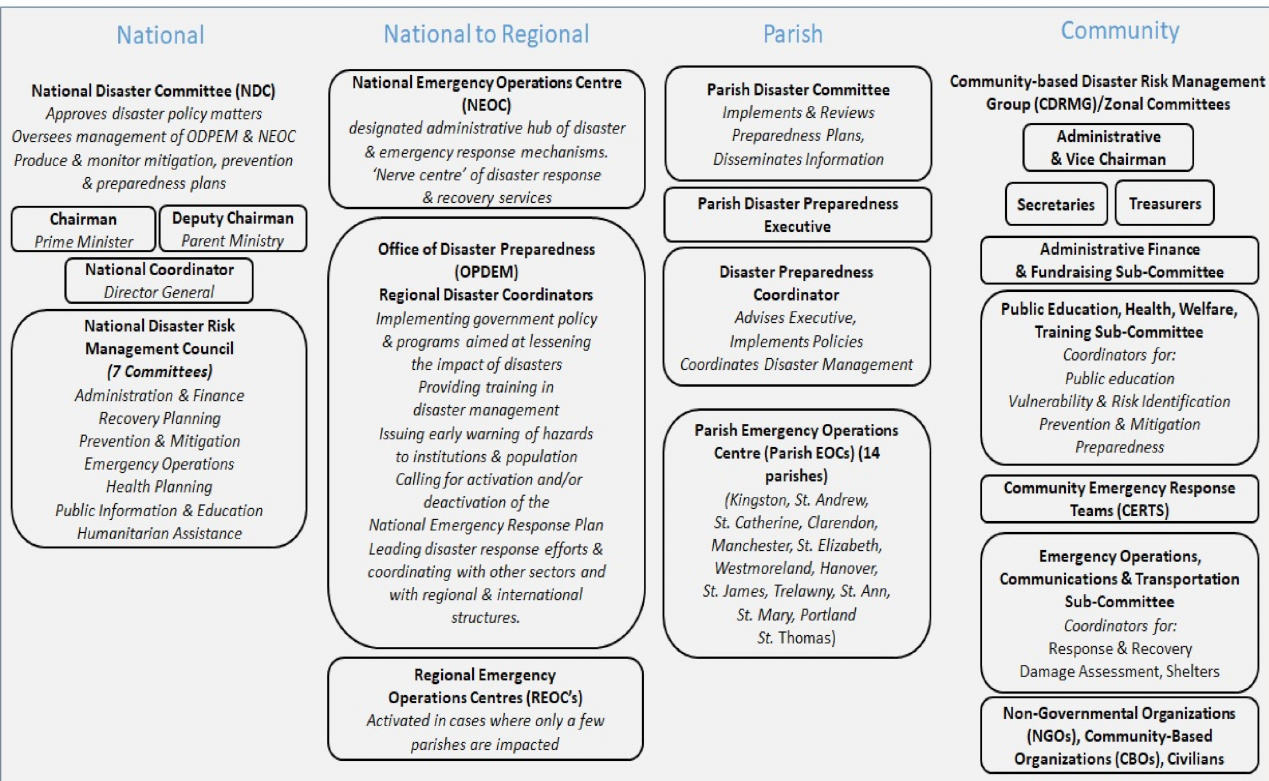
Figure 1. Jamaica’s Disaster Management Framework functions across four mechanism levels, namely: national, regional, parish, and community level—Compiled from multiple sources